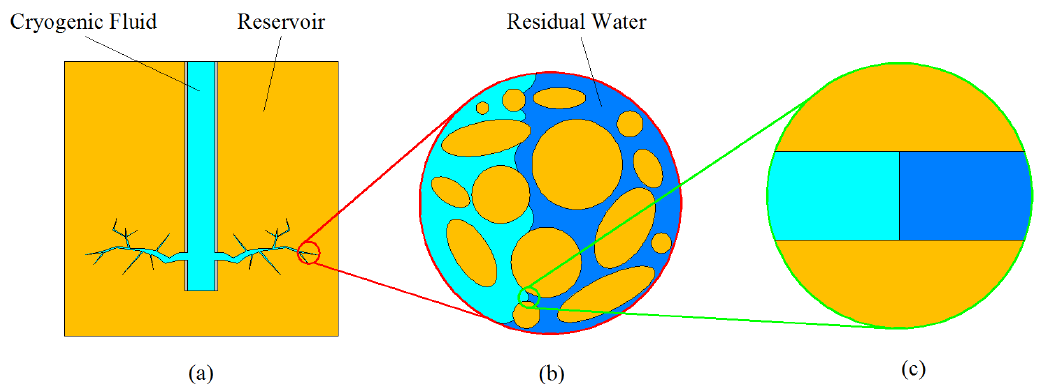
Figure 1. Schematic diagram of the simplification ( a ) practice condition in reservoir ( b ) the simplified model of the reservoir and ( c ) the local area of the simplified model (considered in this paper). Based on the above simplifications, the major e ff ort is spent on simulating the growth of ice phase and the influence of ice phase on the flow status during the displacement process (Figure